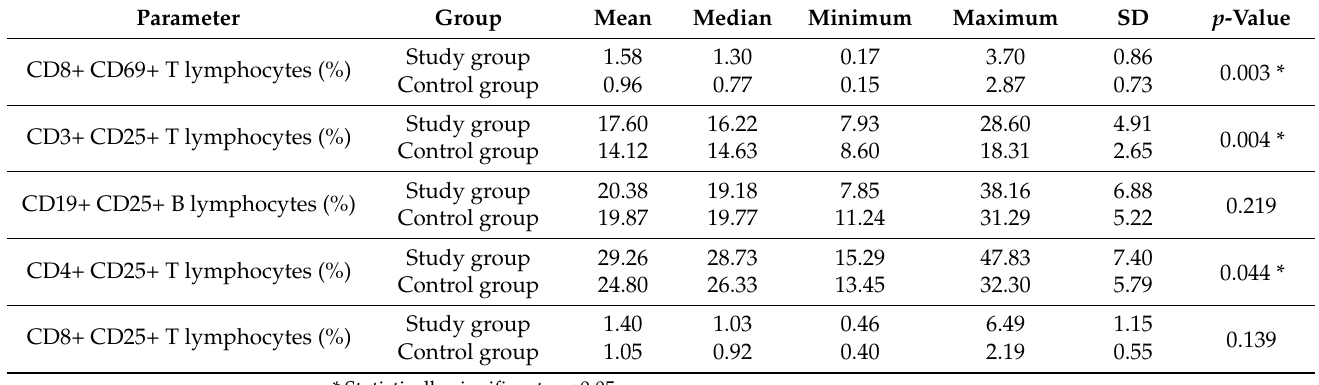
Table 2. Percentage of T and B lymphocytes expressing the CD69 antigen in the study group and the control group.